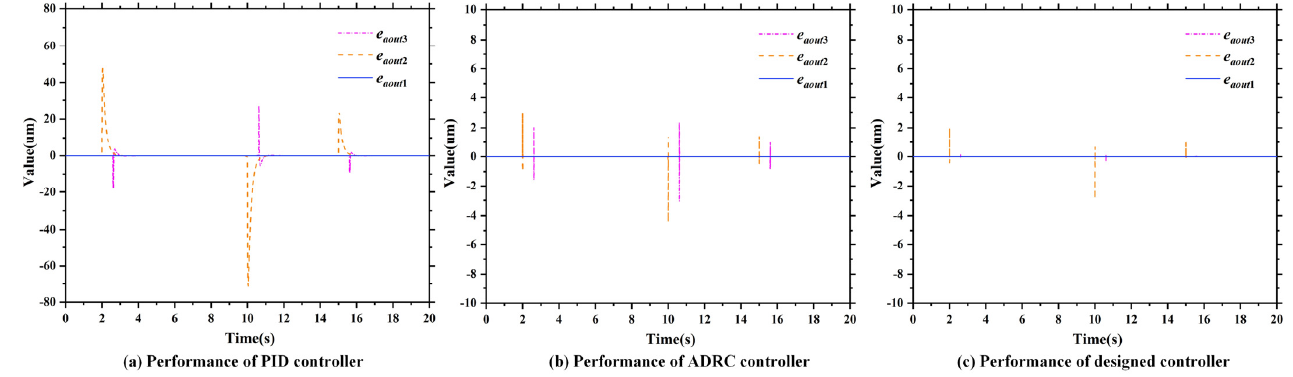
Figure 9. The register error curves under speed disturbance. Table 5. Control range of each controller under speed disturbance.